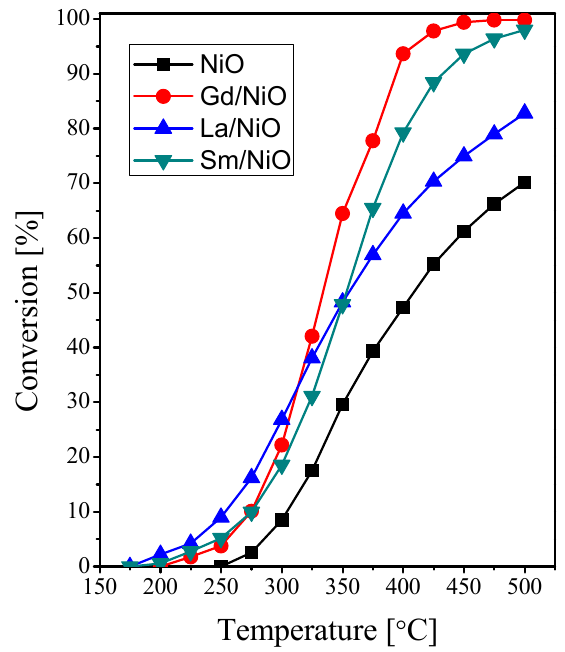
Figure 9. The in fl uence of the reaction temperature on the N 2 O conversion over NiO and its RE ‐ Figure 9. The influence of the reaction temperature on the N 2 O conversion over NiO and its promoted catalysts. RE-promoted